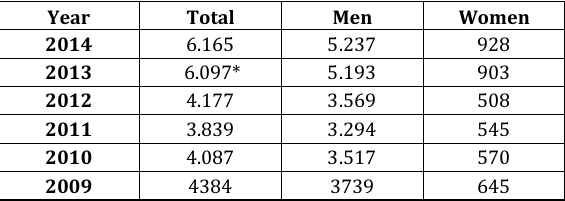
Table. 1 Number of suicidal attempts resulting in death (statis- tical data according to Main Police Headquarters.)[3] Total Men